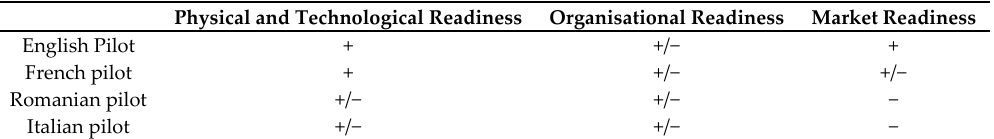
Table 2. Comparison of readiness levels at the 4